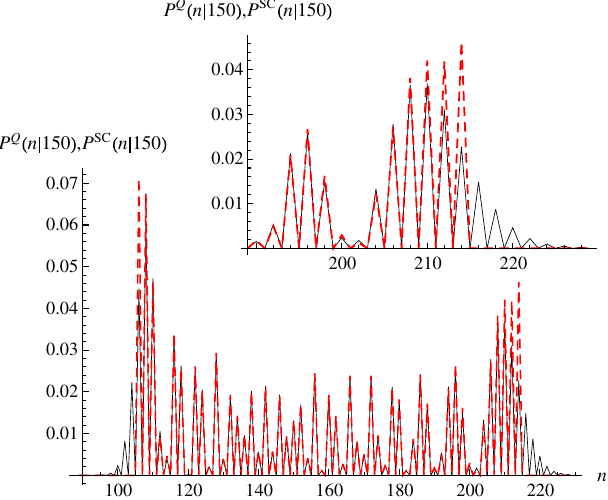
FIG. 5. A comparison of quantum and semiclassical transition probabilities for our model system. The black solid curve shows P Q ð n j m Þ , while the red dashed curve shows P SC ð n j m Þ , as given by Eq. (49). All of the parameters are the same as those in Fig.